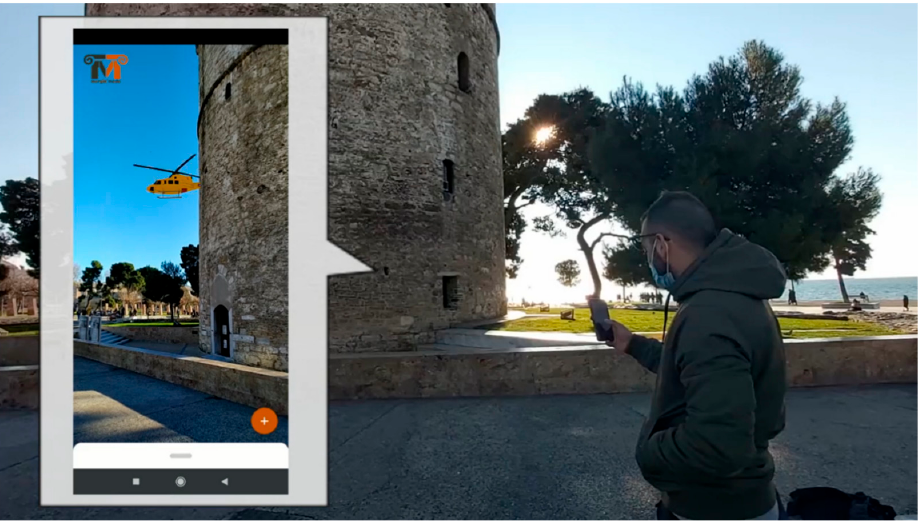
Figure 7. MR experience in the field: the virtual helicopter is partially covered by the monument.